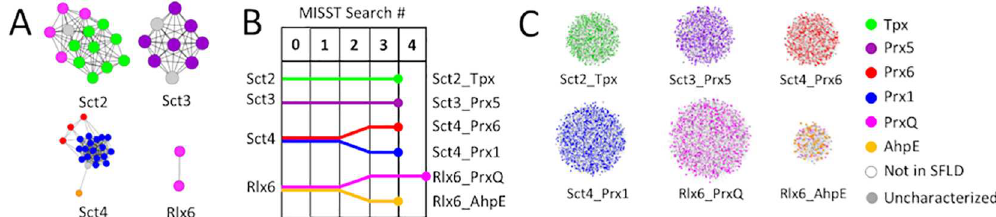
Fig 2. Four TuLIP groups split into six functionally relevantgroups afterfive MISST iterations. (A) The four TuLIP groupsarerepresentedby networksin whicheachnoderepresentsa Prx proteinof knownstructure. Edgesare pairwiseprofilescores(as definedin [54])andnodecolorsrepresentexpertfunctional annotations(see legend).(B) A dendrogram of the iterative MISST processillustrateshowthe initialTuLIP groupsevolvedinto the finalMISST groups. VerticallinesrepresentGenBanksearches anddendrogram linesare coloredbasedon the majoritysubgroup in each MISST cluster. Dendrogram branchesrepresentthe cluster subdivision via PSSM Analysis.The circleat eachline terminusrepresentsthe iterationat whichthe groupmet self-identification criteria(see Methods). (C) The finalsix Prx groupsarerepresentedas networksin whichnodesrepresentthe proteinsandedgesrepresentthe DASP2search scoresfrom the finalsearch;the nodesarecoloredby expertsubgroupannotationpreviously